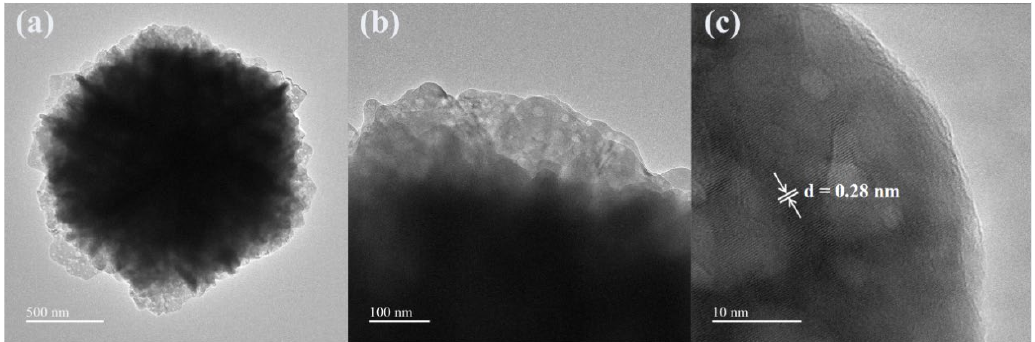
Figure 4. TEM and HRTEM images of the ZnO nanosheet flowers prepared at a malic acid concentration of 15 mmol: ( a ) low- and ( b ) high- magnification TEM images , and ( c ) HRTEM image.